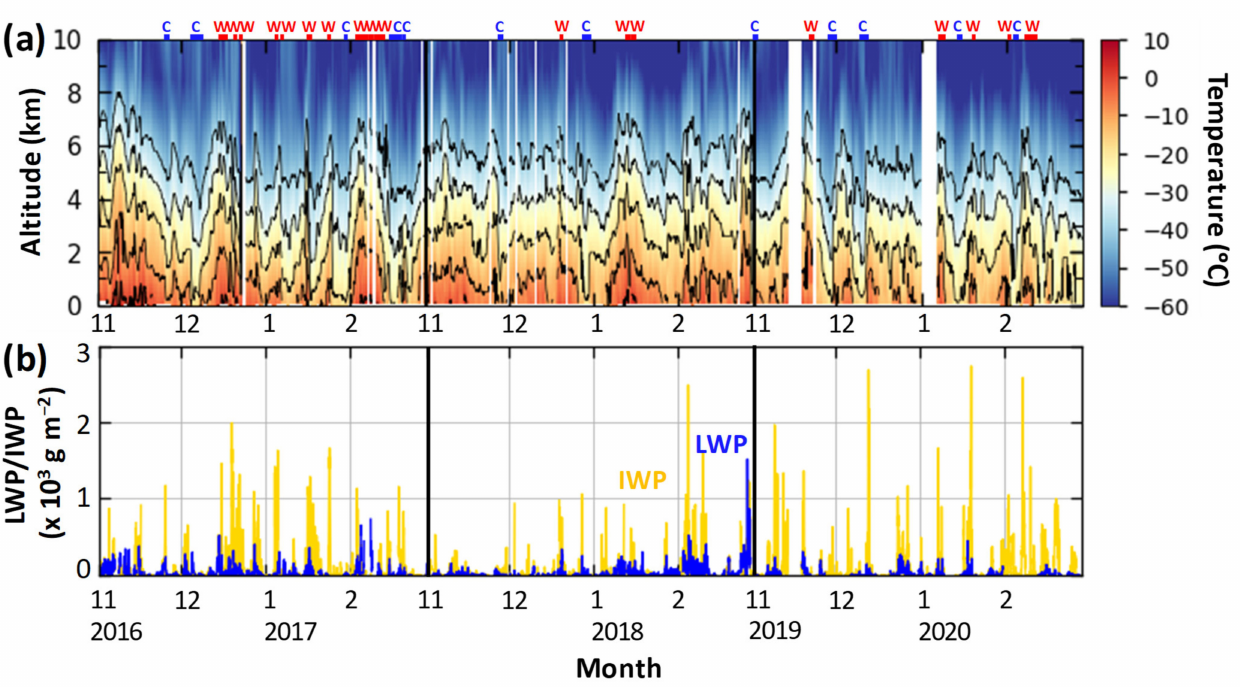
Figure 3. ( a ) Time–height plot of air temperatures and ( b ) a time series of LWP (blue)/IWP (yellow) during multi-year winter (November–February). Red and blue boxes labeled “W” and “C” on top of ( a ) indicate warm and cold air mass periods,